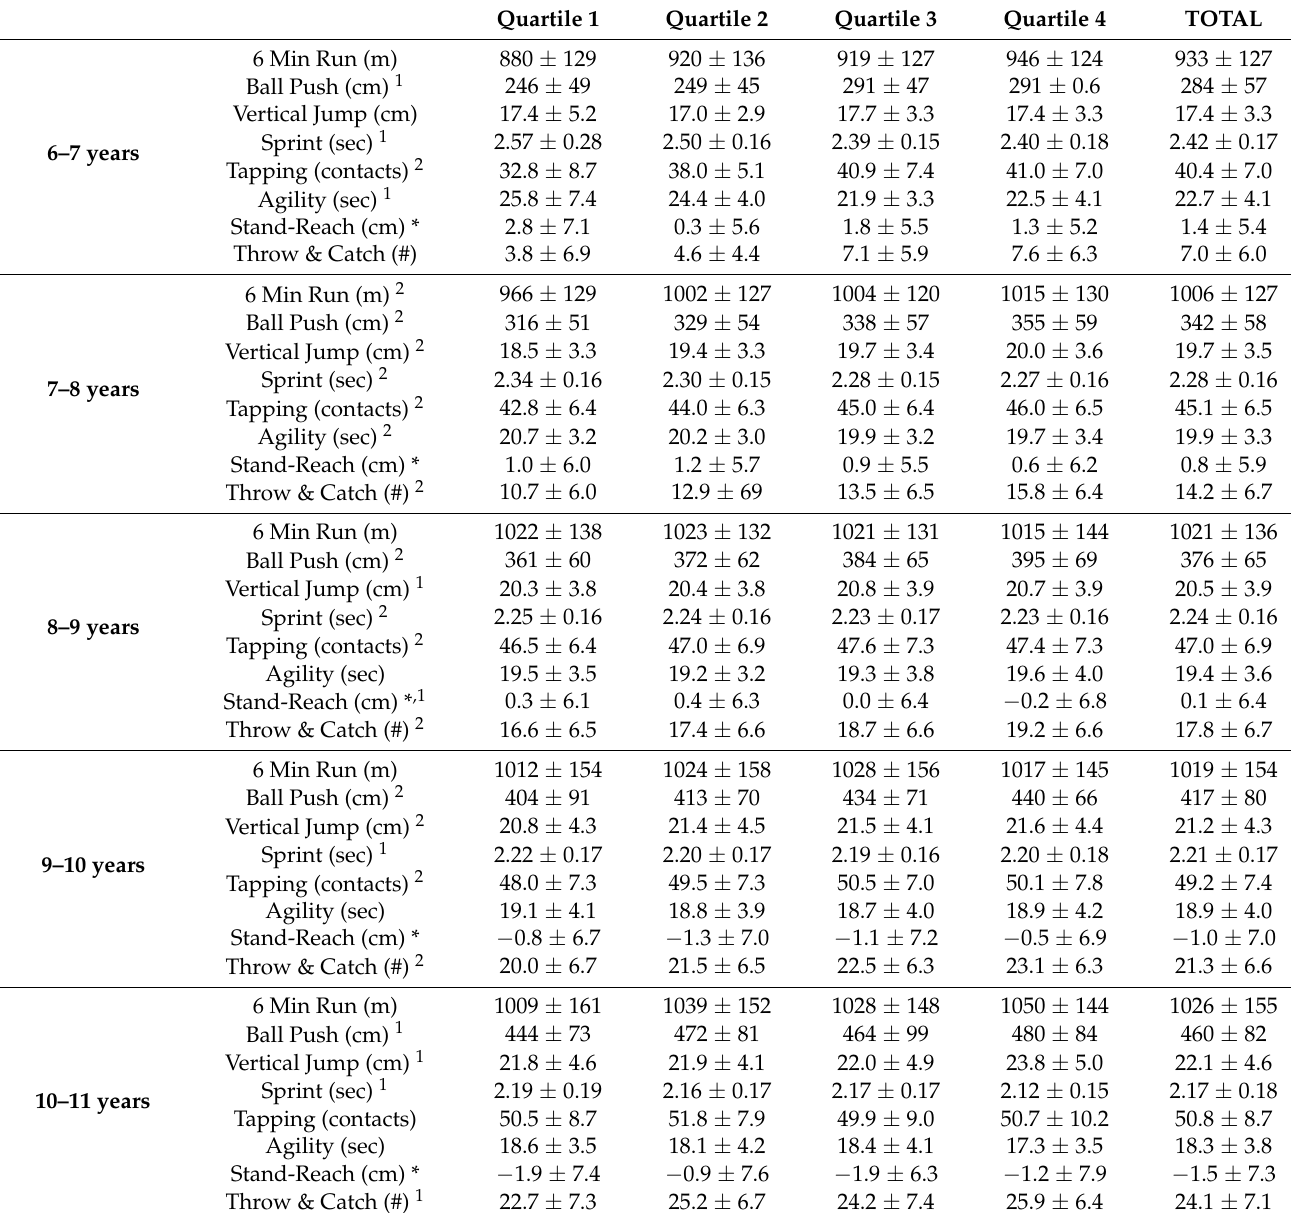
Table 3. Physical fitness by age-group and age-specific quartile in boys.